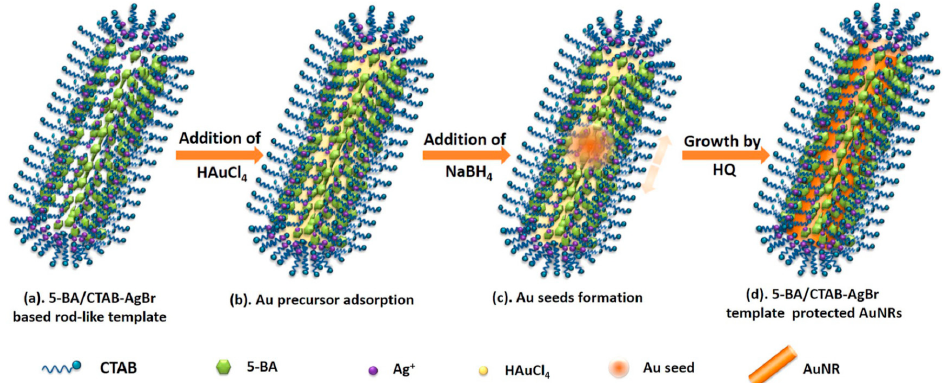
Figure 5. Scheme of seedless synthesis technique based on the use of 5-bromosalicylic acid and hydroquinone. Reproduced from [38] with permission from the John Wiley and Sons.